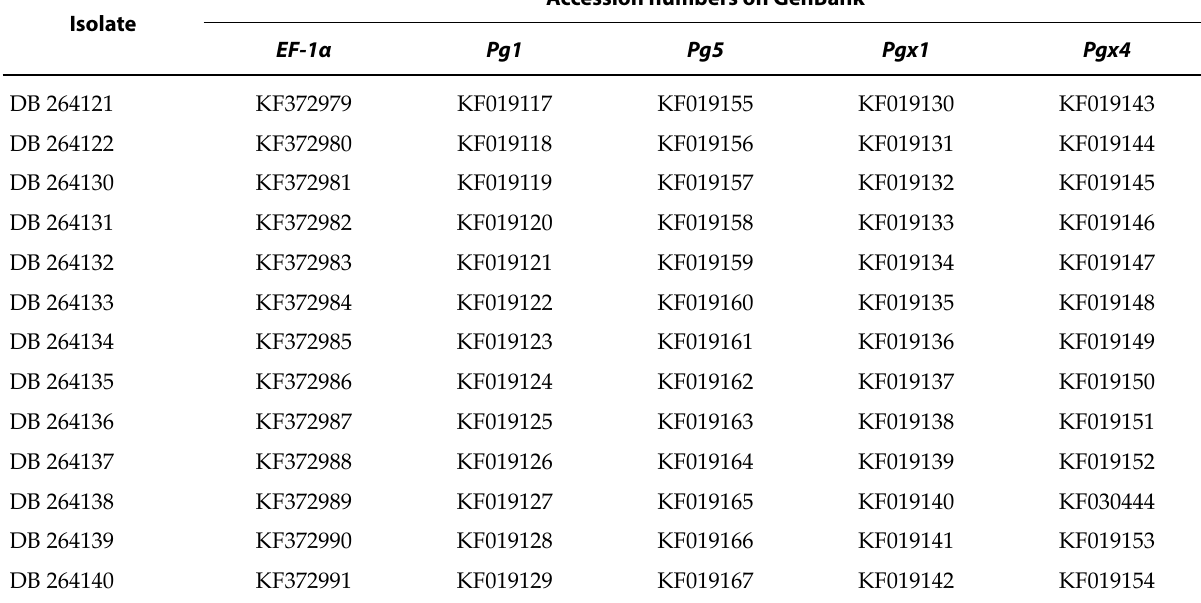
Table 3. Accession numbers of EF-1α , Pg1 , Pg5 , Pgx1 and Pgx4 gene sequences obtained from Fusarium oxysporum isolates from Echeveria agavoides, and deposited in GenBank